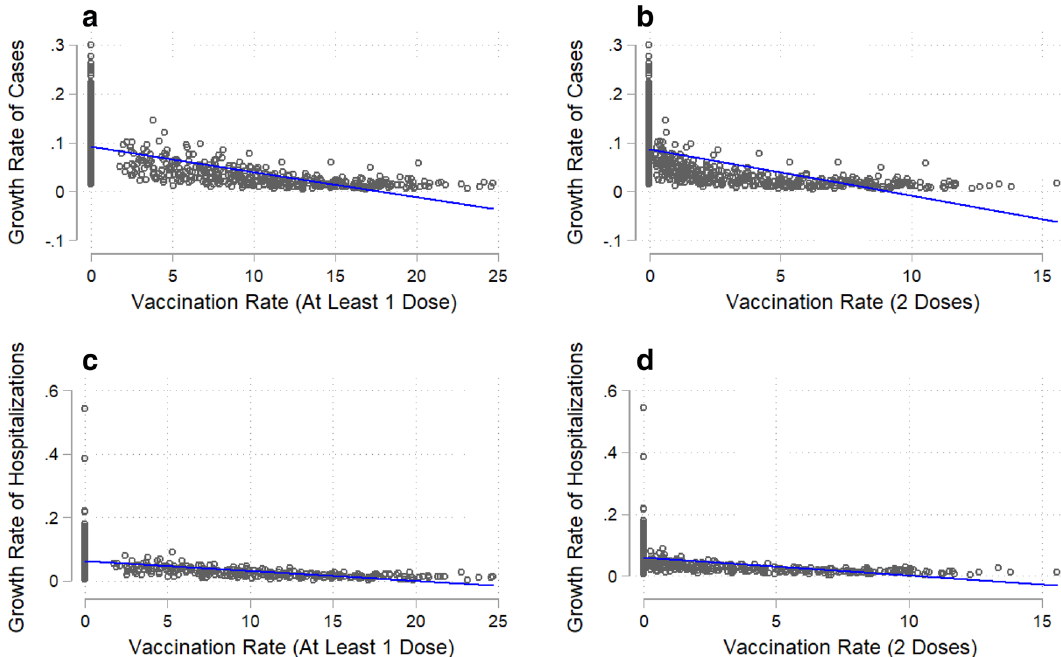
Figure 2. COVID-19 infections (total cases and hospitalizations) and vaccination rate. Vaccination rate is the number of individuals vaccinated per hundred. The solid line in each figure is a fitted linear curve between the growth rate of total cases/hospitalizations and vaccination rate. ( a ), Association between the growth rate of total cases and at least 1 dose of vaccination (coefficient = − 0.006, R 2 = 35.3%). ( b ) Association between the growth rate of total cases and 2 doses of vaccination (coefficient = − 0.013, R 2 = 28.6%). ( c ) Association between the growth rate of total hospitalizations and at least 1 dose of vaccination (coefficient = − 0.003, R 2 = 20.8%). ( d ), Association between the growth rate of total hospitalizations and 2 doses of vaccination (coefficient = − 0.007, R 2 =